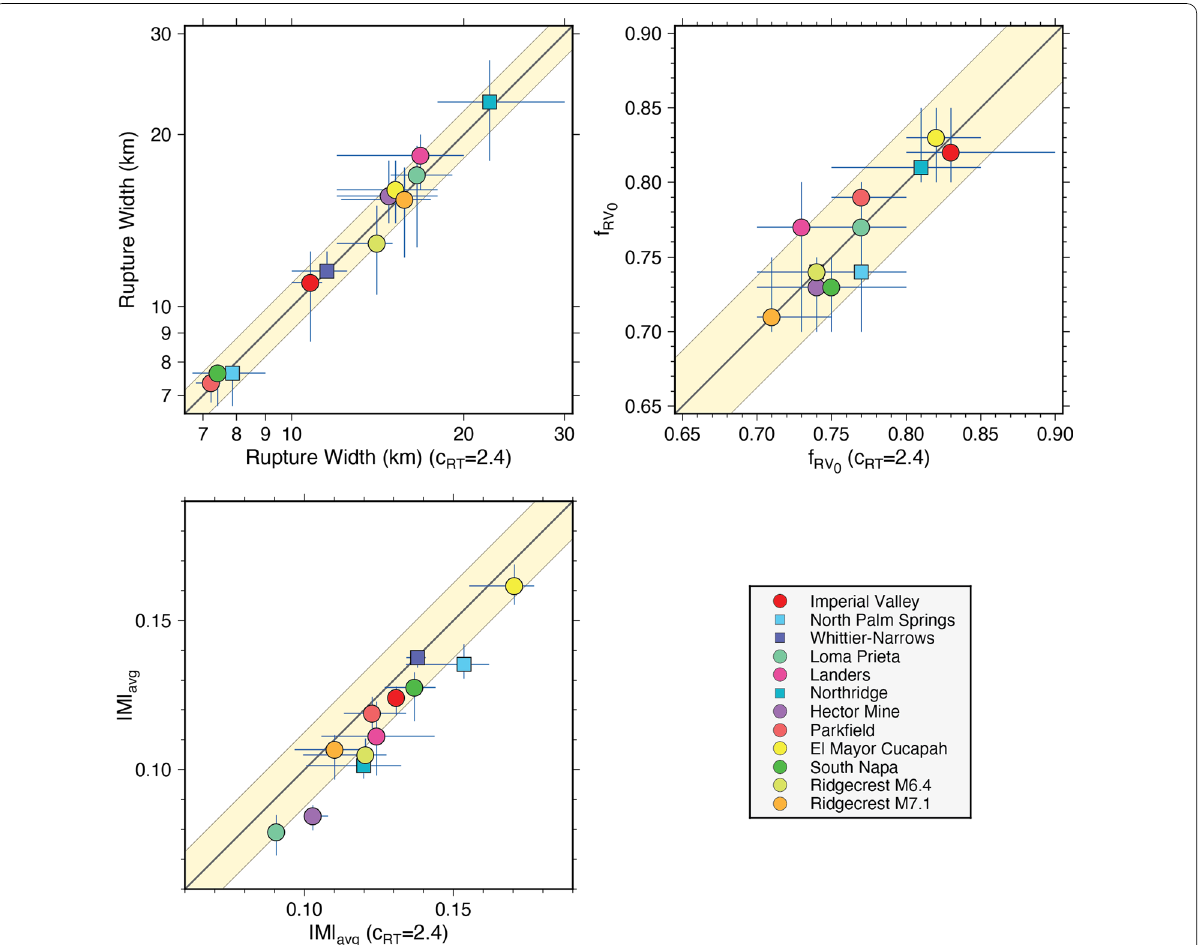
Fig. 17 Comparison of fault width (upper left), f RV0 (upper right) and | M | avg (lower left) for the five lowest misfit realizations with c RT allowed to vary (vertical axis) and c RT fixed at 2.4 (horizontal axis). Symbols are plotted at the mean values and the horizontal and vertical bars indicate the range of minimum and maximum parameter values across the five lowest misfit realizations. The gray line denotes 1:1 scaling and the yellow shading indicates regions of ± 10%, ± 5% and ± 10% about the 1:1 line for fault width, f RV0 , and | M | avg ,